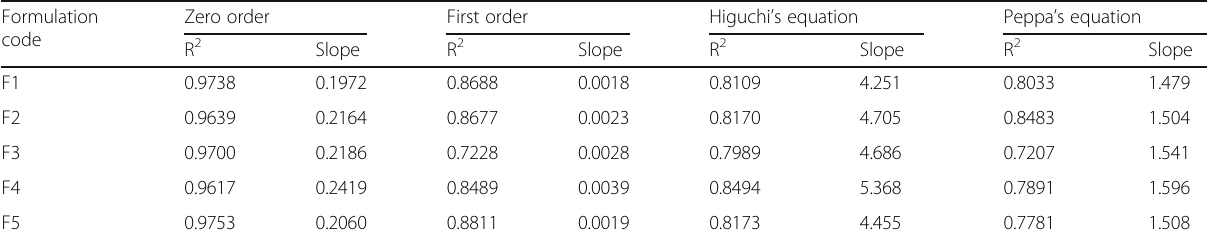
Table 3 Kinetic modeling of drug release from herbal gel formulations Formulation code